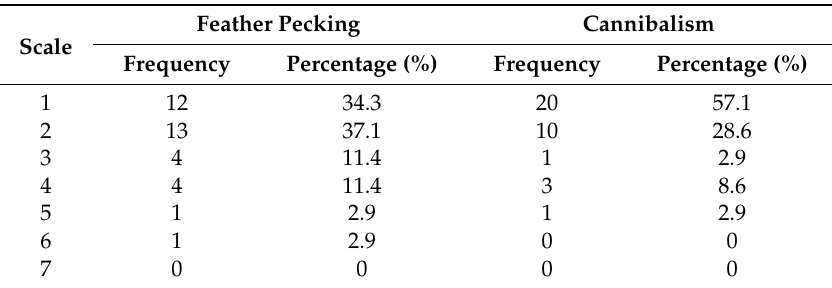
Table 2. The seriousness of feather pecking (a) and cannibalism (b) estimated by Finnish laying hen farmers ( n = 35), on a scale from 1 (not serious) to 7 (extremely serious). Feather Pecking Cannibalism Scale Frequency Percentage (%) Frequency Percentage (%) 1 12 34.3 20 57.1 2 13 37.1 10 28.6 11.4 2.9 11.4 8.6 2.9 0 0 0